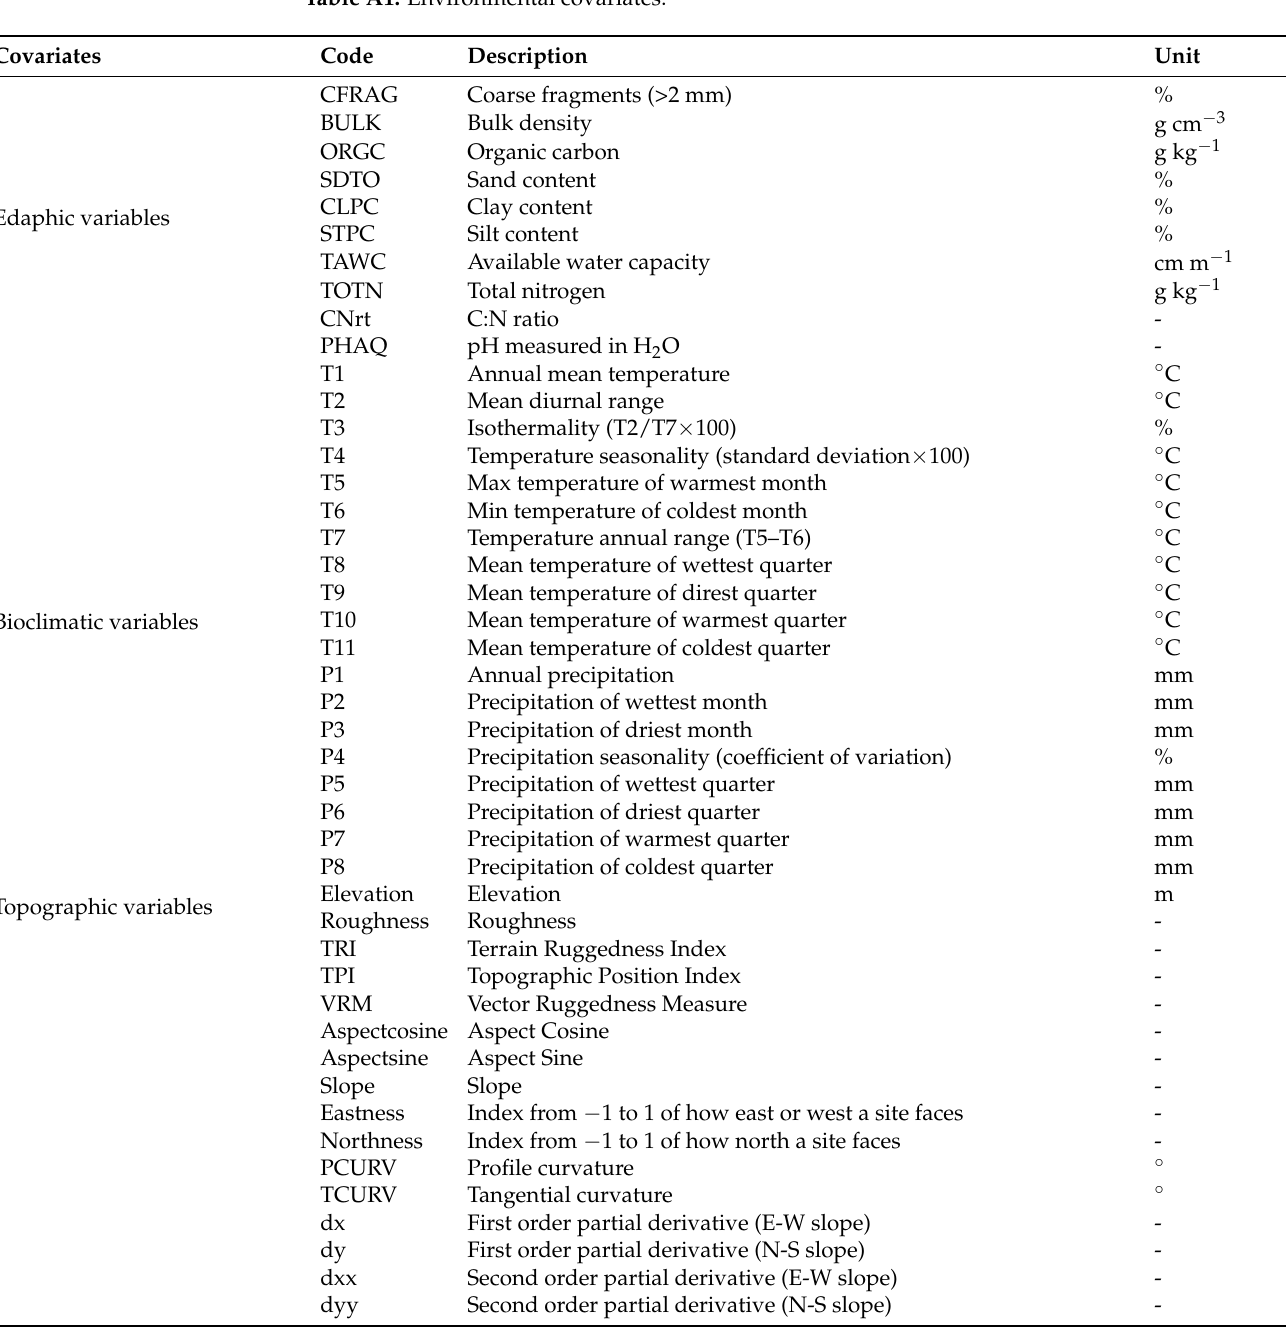
Table A1. Environmental